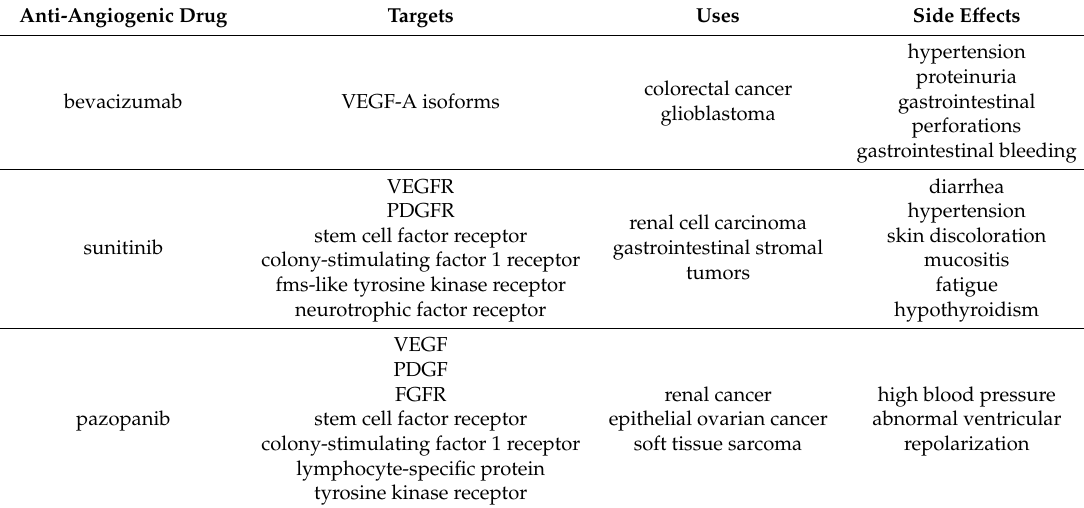
Table 2. The most common anti-angiogenic drugs applied for cancer